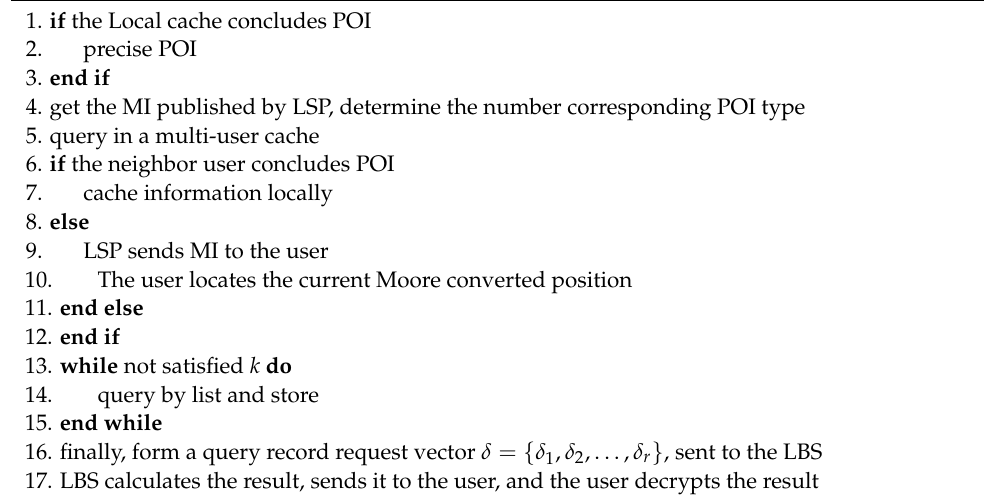
Algorithm 3 Query